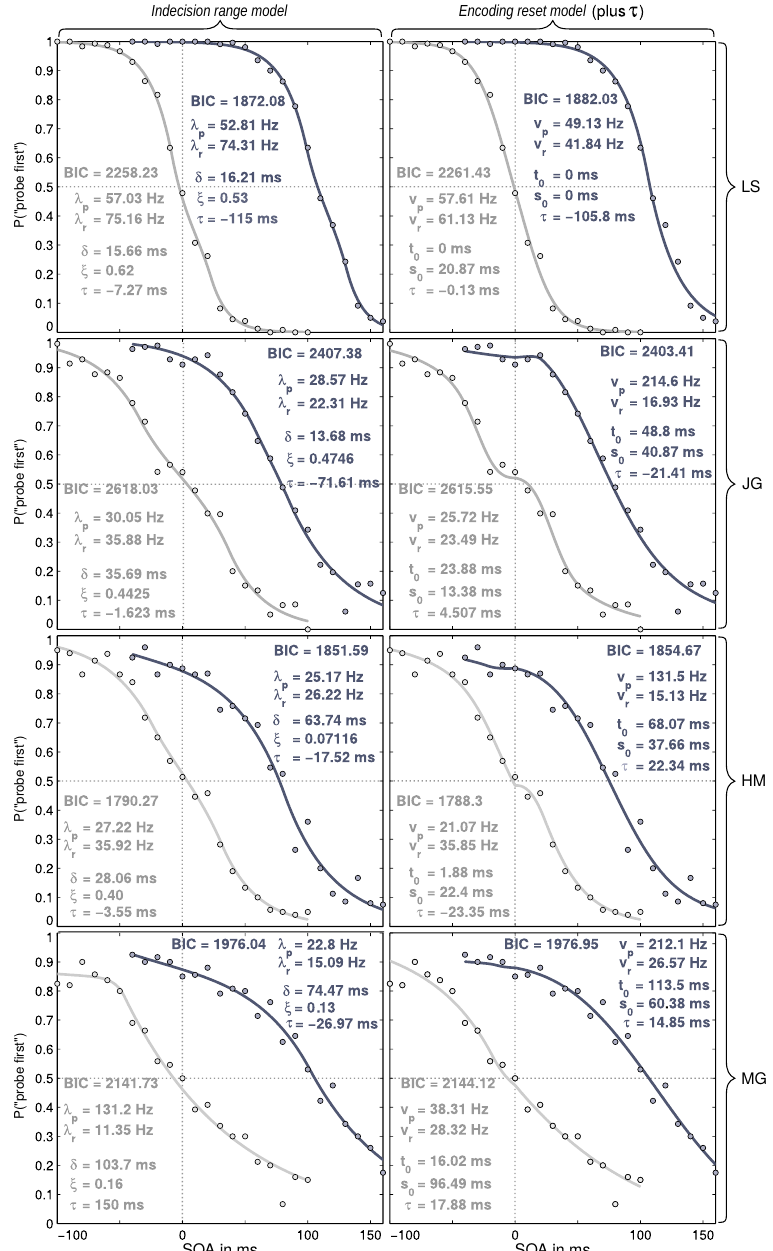
Figure 4. Data, fits, and parameters in Experiment 2. The rows show the different participants, labeled with initials. The columns are the different models, identified in the heading at the top. The cued condition is shown in dark gray, the uncued control condition in light gray. Data points are the frequencies of the judgment “probe first” for the 21 stimulus onset asynchronies (SOAs) studied. In each panel, the respective Bayesian information criterion (BIC) score and all used parameters are given; model parameters as in Figure 3. In addition, parameter τ indicates the position of the plateau on the x -axis. For detailed definitions of the parameters, please refer to Section